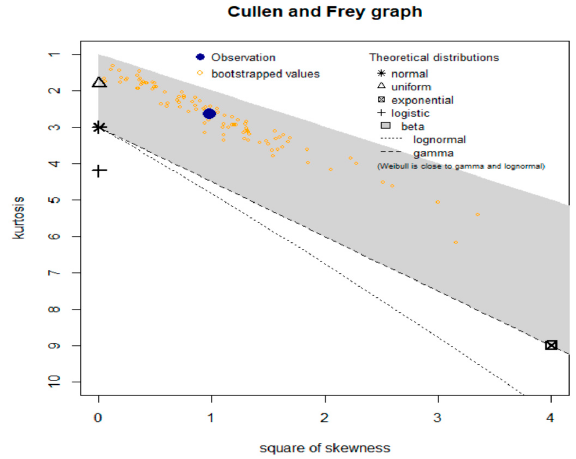
Figure 10. Cullen - Frey panel for the actuarial claims data.